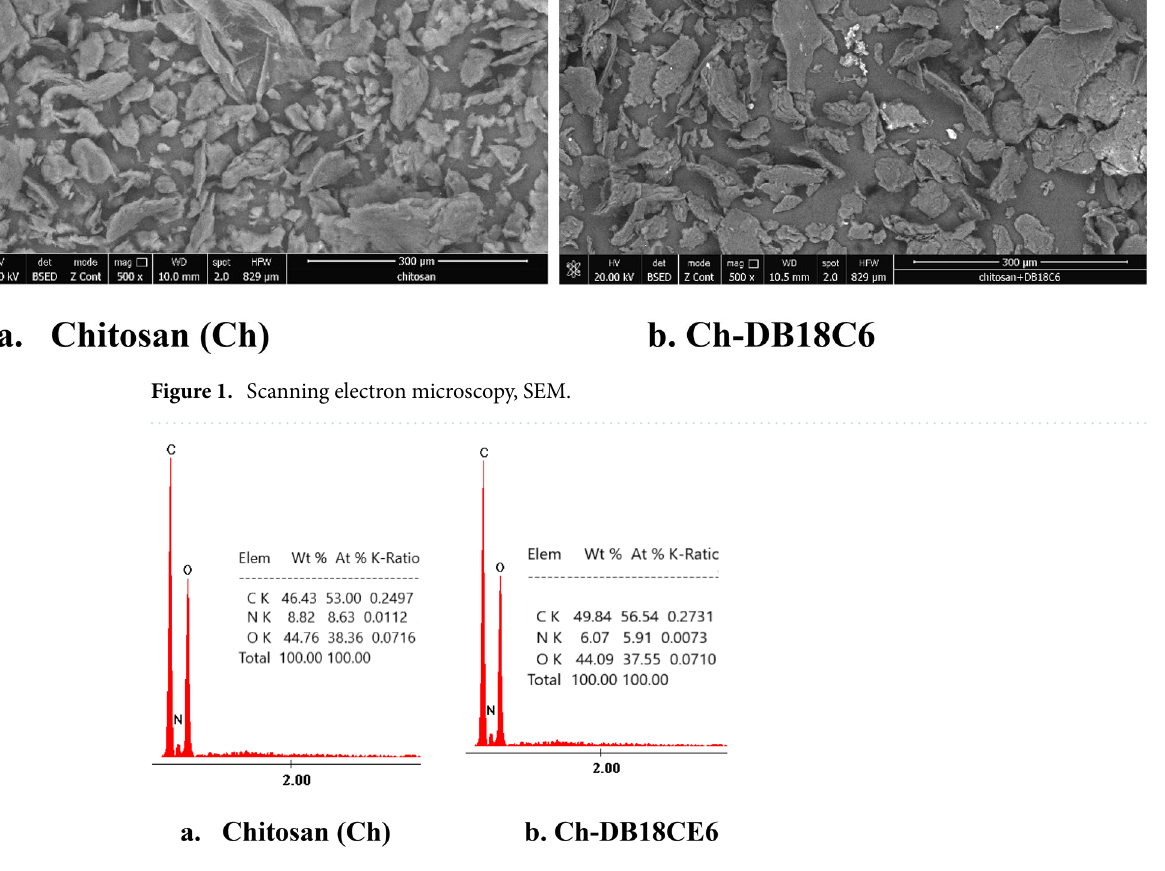
Figure 2. Energy-dispersive X-ray spectroscopy,